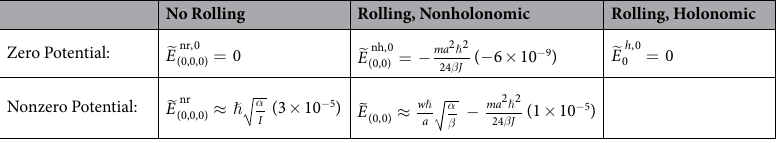
Table 1. Expressions for the ground state energies of five special cases of the molecular wheelbarrow model; numbers in parentheses are corresponding predicted energies (in eV) of the molecular wheelbarrow studied in 5